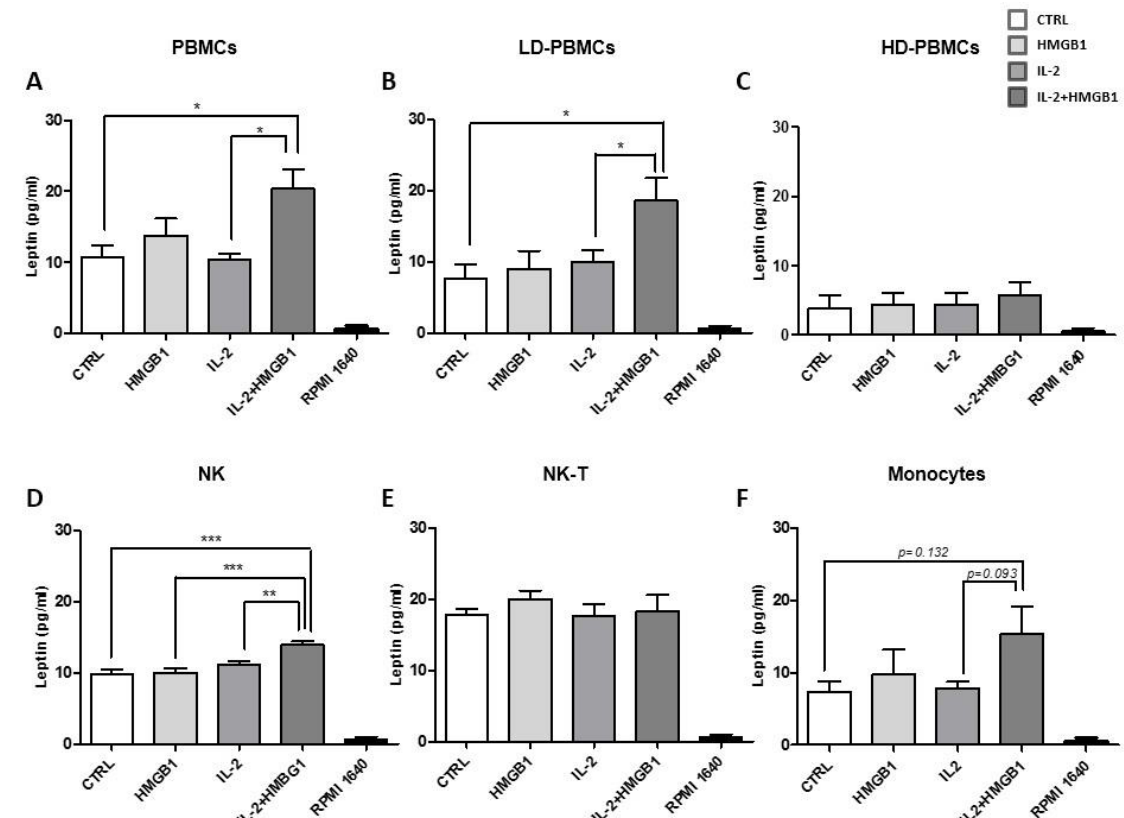
Figure 3. Leptin concentrations were measured by ELISA assay after IL-2 and/or HMGB1 treatments. ( A ) IL-2 and HMGB1 co-treatment induced a significant increase in leptin secretion, while IL-2 or HMGB1 did not cause any raise. PBMCs were sorted using Percoll gradient and separated in low-density PBMCs and high-density PBMCs; ( B ) low-density PBMCs had a significant increment in leptin secretion after IL-2 and HMGB1 co-treatment; ( C ) high-density PBMCs fraction had the lowest secretion of leptin with no enhancement after all treatments; ( D ) isolated NK cells secreted leptin in basal conditions with an additional significant increase in response to IL-2 and HMGB1 co-treatment; ( E ) isolated NK-T cells released the highest amount of leptin without variations after all treatments. ( F ) Isolated monocytes did not show any significant increase in leptin secretion. Leptin was not found in RPMI1640. Each subpopulation has been treated in triplicate, from healthy donors ’ buffy coat. Data are expressed as mean ± SEM and were analyzed with a Wilcoxon – Mann – Whitney U Test (* p = 0.05, ** p < 0.005, *** p < 0.0005). CTRL: control; HMGB1: High Mobility Group Box1; IL-2: Interlukin-2; PBMC: peripheral blood mononuclear cells; LD-PBMCs: low density peripheral blood mononuclear cells; HD-PBMCs: high density peripheral blood mononuclear cells; NK: Natural Killer; NK-T: Natural Killer-T.